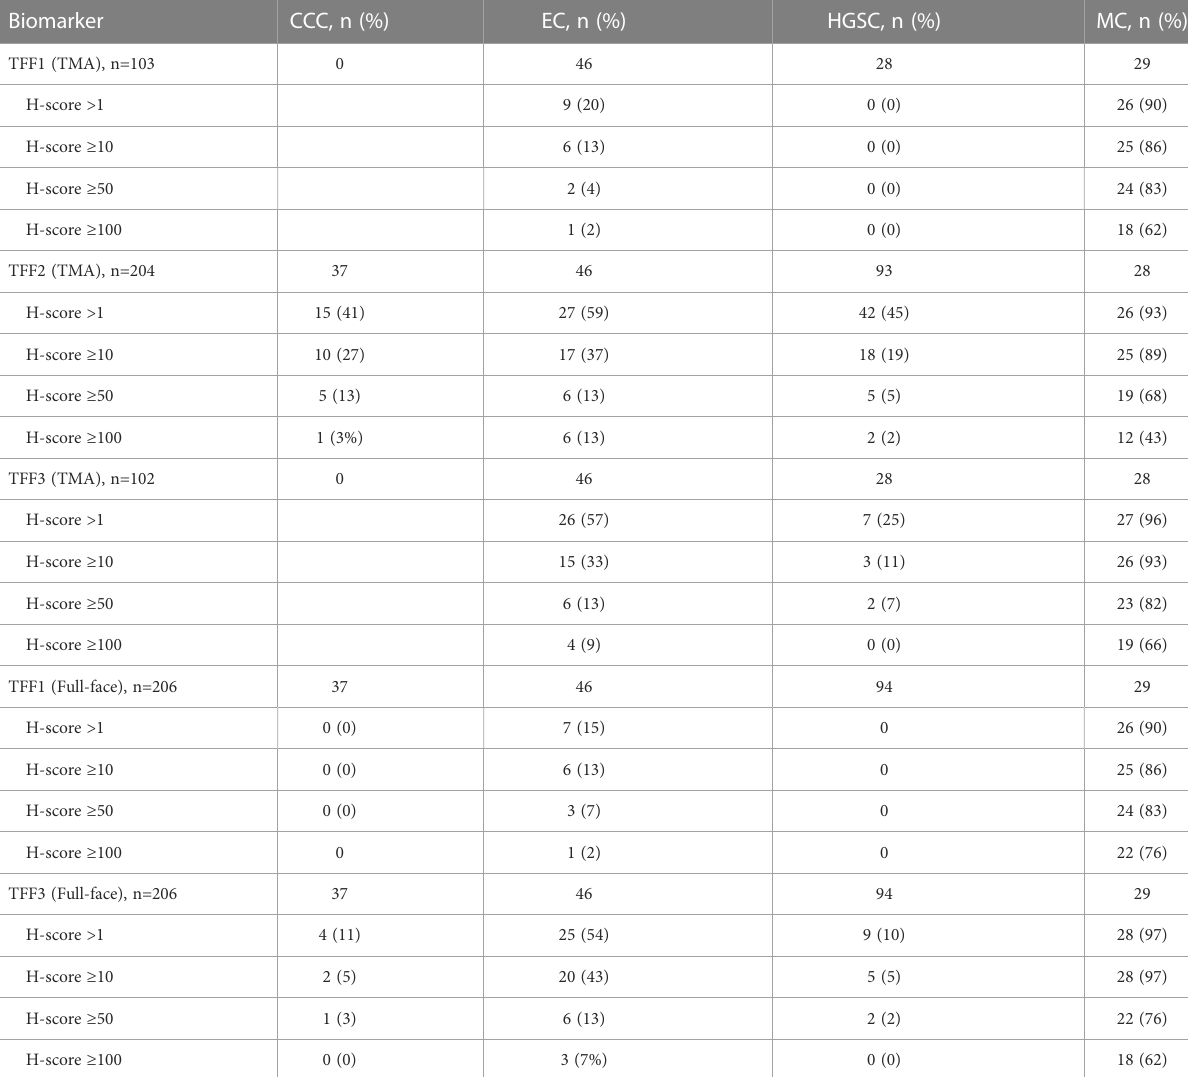
TABLE 3 Frequency of protein expression in different OC (ovarian cancer) histotypes according to arbitrary H-score cut-off values.